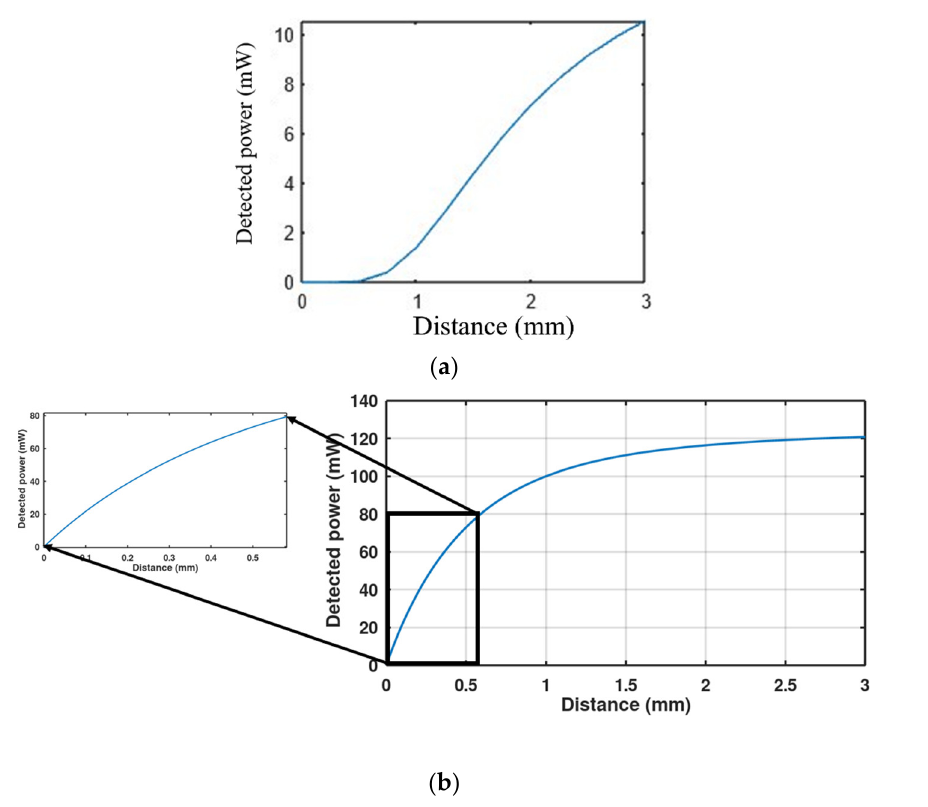
Figure 6. The change in power incident on the detector with the proof mass position distance from LED in the vertical direction for ( a ) a 15 ◦ narrow-angle LED, ( b ) a 60 ◦ wide-angle LED. The inset is a zoom on the short distance range.